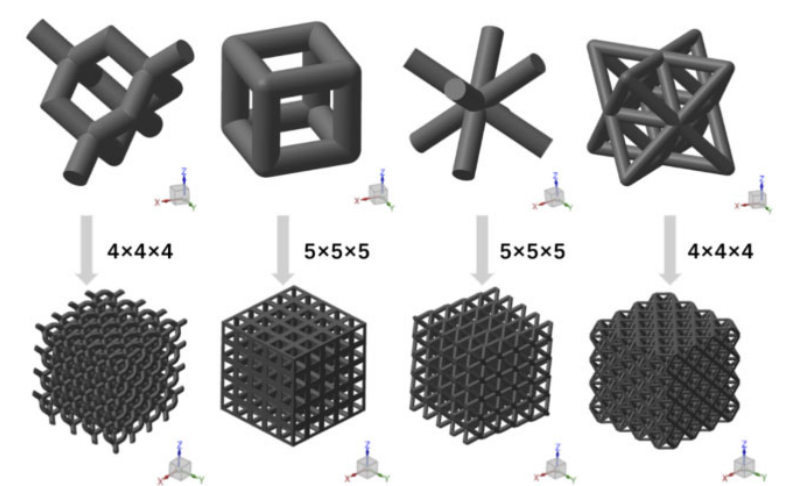
Fig. 45 3D models for Al 2 O 3 ceramic cellular structures. Reproduced with permission from Ref. [121], © Elsevier B.V. 2019.